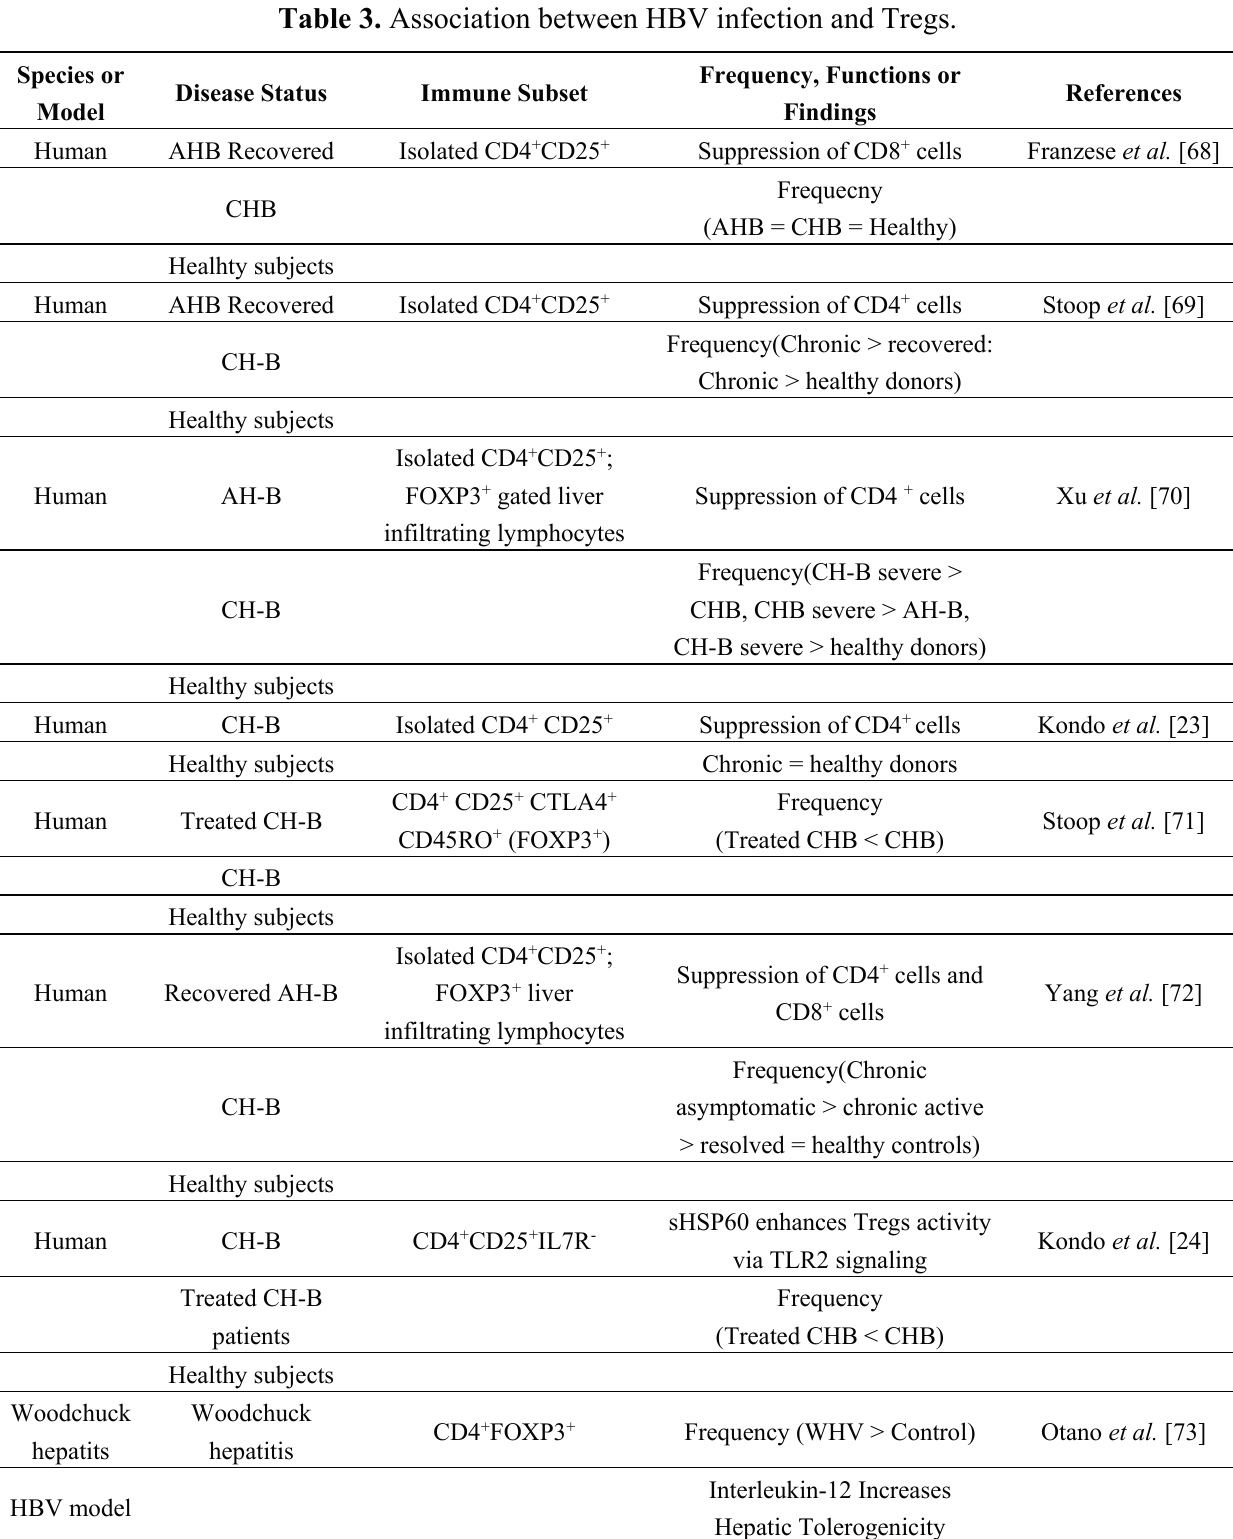
Table 3. Association between HBV infection and